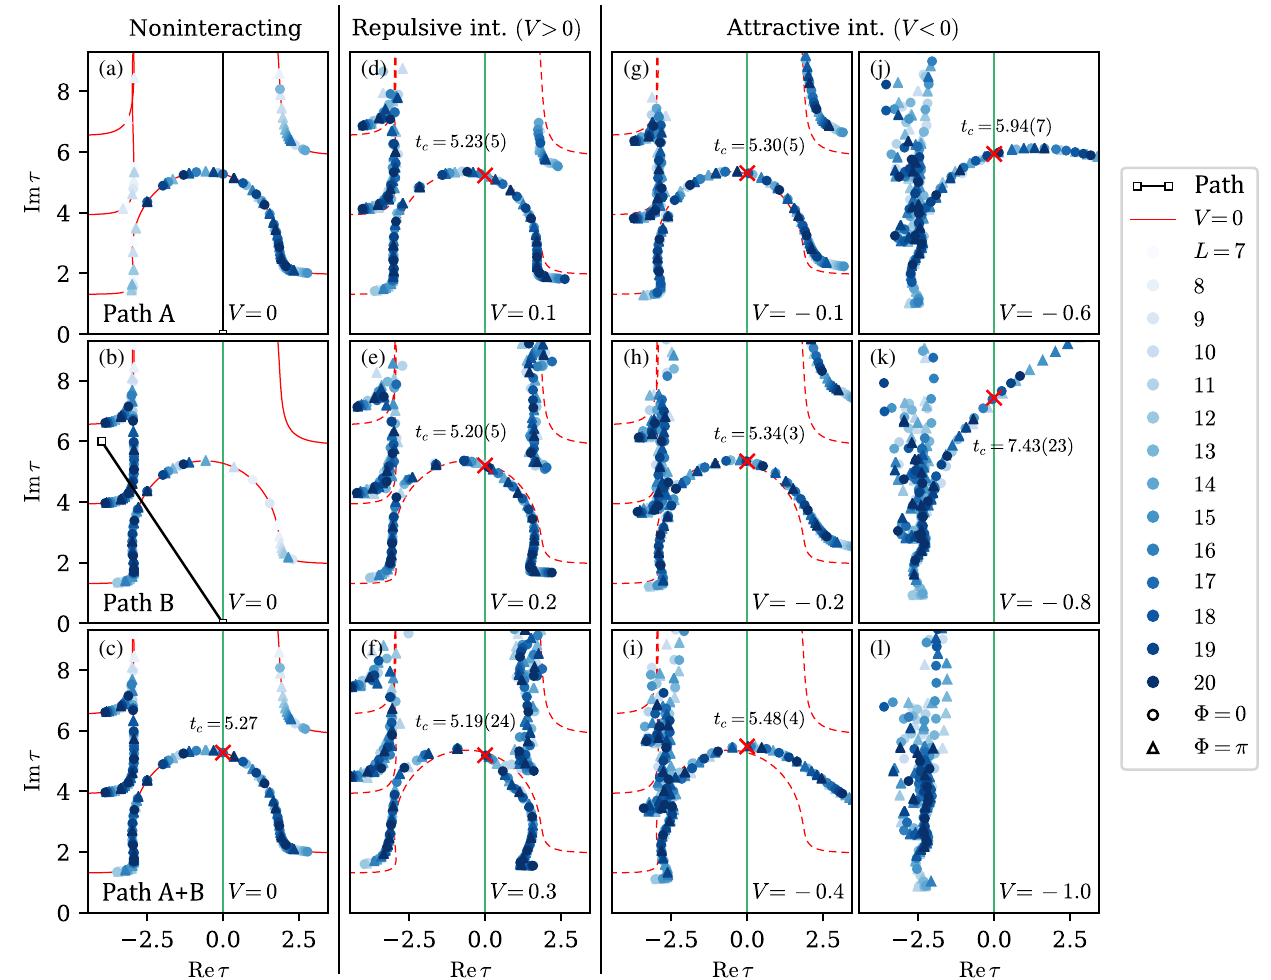
FIG. 2. Interacting Kitaev chain. We quench the chemical potential from the trivial phase μ ¼ − 1 . 4 to the topological phase μ ¼ − 0 . 2 for t > 0 with fixed Δ ¼ 0 . 3 (all parameters and the inverse time τ − 1 are expressed in units of J ¼ 1 ). (a) – (c) Complex zeros for different system sizes ( L ¼ 7 – 20 ) and boundary conditions ( Φ ¼ 0 ; π ) in the noninteracting case, compared with the exact thermodynamic lines of zeros. Only the zeros within a finite range from the basepoint can be accurately obtained from the Loschmidt cumulants. This fact is illustrated by moving the basepoint τ along two different paths [paths A and B in panels (a) and (b)]. Panel (c) combines the results from panels (a) and (b). (d) – (f) Loschmidt zeros and critical times obtained with repulsive interactions ( V > 0 ) along the two paths. The lines of zeros for V ¼ 0 (dashed line) are shown for comparison. The critical time t c , shown in each panel as a red cross, is obtained as the intersection between the imaginary axis and the line drawn from the zero τ − with the smallest negative real part (in absolute value) to the zero τ with the smallest positive real part. The error on the critical time is estimated as Δ t c ¼ max ðj t c − Im τ − j ; j t c − Im τ þ Evolution of zeros and critical times with increasing attractive interactions ( V < 0 ). For very strong interactions [ V ¼ − 1 , panel (l)], the zeros do not cross the imaginary axis, signaling the absence of a dynamical quantum phase transition. As discussed in Appendix B, the numerical error in the zeros is of the order of 10 − 3